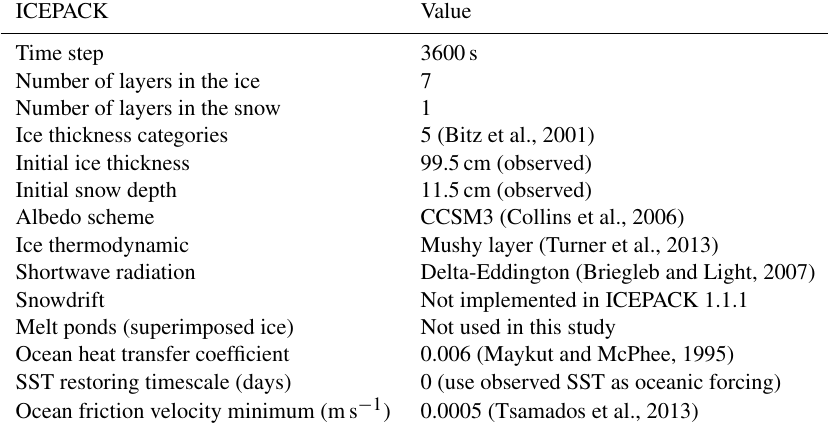
Table 1. Detailed options of physical parameterizations and model settings for ICEPACK. SST signifies sea surface temperature. ICEPACK Value Time step 3600s Number of layers in the ice 7 Number of layers in the snow 1 Ice thickness categories 5 (Bitz et al., 2001) Initial ice thickness 99.5cm (observed) Initial snow depth 11.5cm (observed) Albedo scheme CCSM3 (Collins et al., 2006) Ice thermodynamic Mushy layer (Turner et al., 2013) Shortwave radiation Delta-Eddington (Briegleb and Light, 2007) Not implemented in ICEPACK